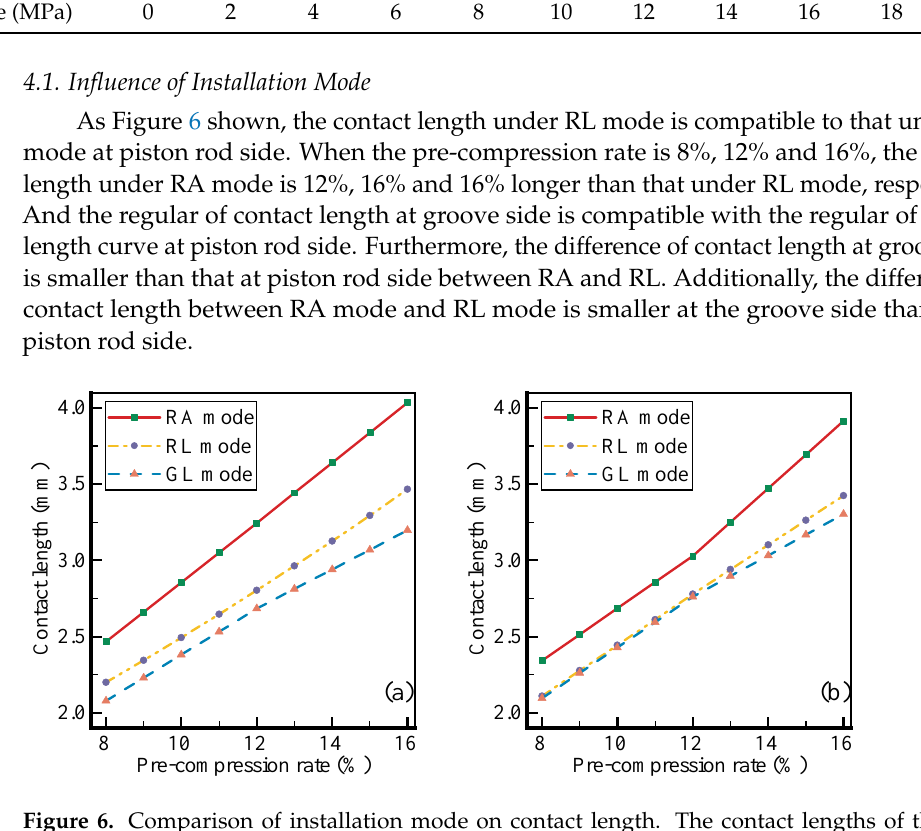
Figure 6. Comparison of installation mode on contact length. The contact lengths of the three installation modes are shown in ( a ) for piston rod side and in ( b ) for groove side, respectively. The three installation modes, including piston rod with axial displacement (RA mode), piston rod with lateral displacement (RL mode), and groove with lateral displacement (GL mode). The range of pre-compression rate is set between the maximum and minimum allowable